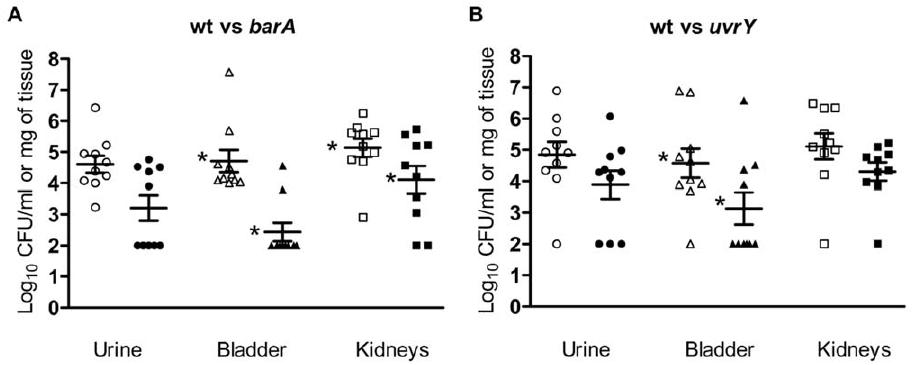
Figure 1. Mutation in barAoruvrY reduces virulence in murine ascending UTI. CBA/J mice were infected transurethrally with mixture of N 5 6 10 7 CFU of WT bacteria and 5 6 10 7 CFU of mutant bacteria. A . Bacteria were recovered 72 hr later from mice infected with CFT073 WT urine ( # ), ), CFT073 WT bladder ( D ), SM3009 ( barA::cm ) bladder ( m ), CFT073 WT kidneys ( % ), SM3009 ( barA::cm ) kidneys ( & ) and SM3009 ( barA::cm ) urine ( were expressed in Log